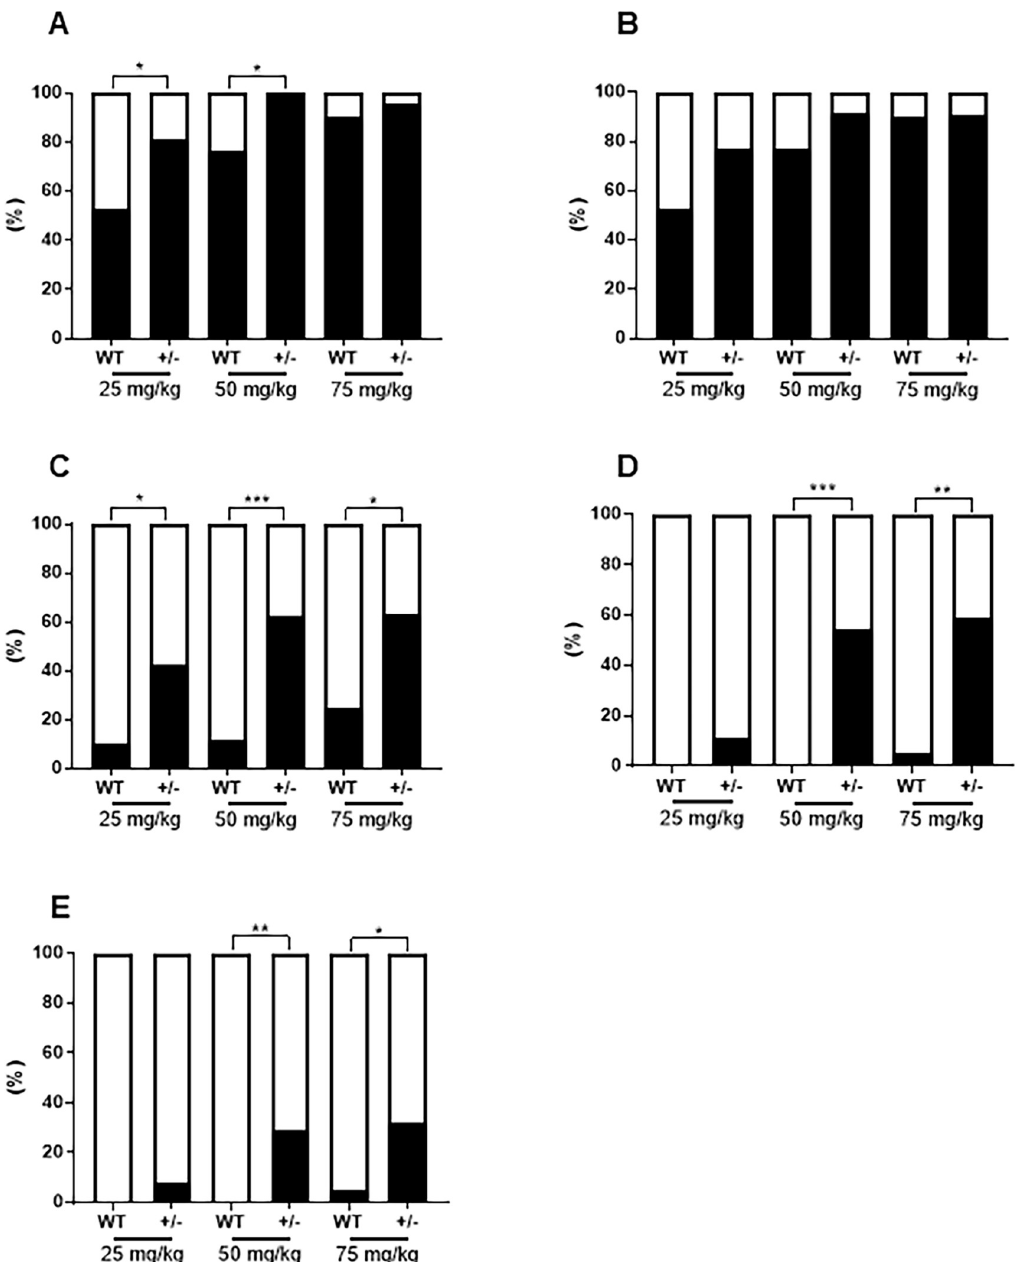
Fig 5. Tumor incidence rate (%) after MNU administration in different dosages. Tumor incidence in each group (A); the incidence of lung tumor (B); the incidence of adenocarcinoma and TML metastasis in the lungs (C); the incidence of thymic malignant lymphoma (TML) in the lungs; and the incidence of TML metastasis (E). � P < 0.05, �� P < 0.01, ��� P < 0.001 versus wild-type mice, as assessed using chi-square test. In a previous short-term carcinogenicity study, a single intraperitoneal injection of 75 mg/ kg MNU as a positive carcinogen was used in B6-Trp53 heterozygous mice [27]. However, there is no data on short-term carcinogenicity tests using FVB-Trp53 mice. Therefore, in this study, to select the dose of MNU as a positive control in FVB-Trp53 +/- mice, 26-week short-